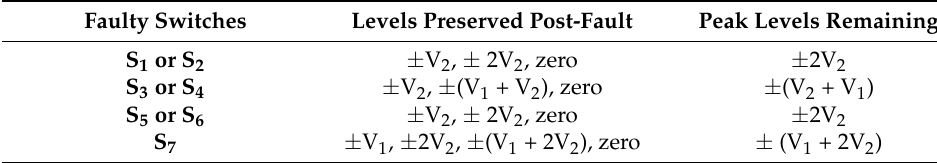
Table 2. Fault management strategy.